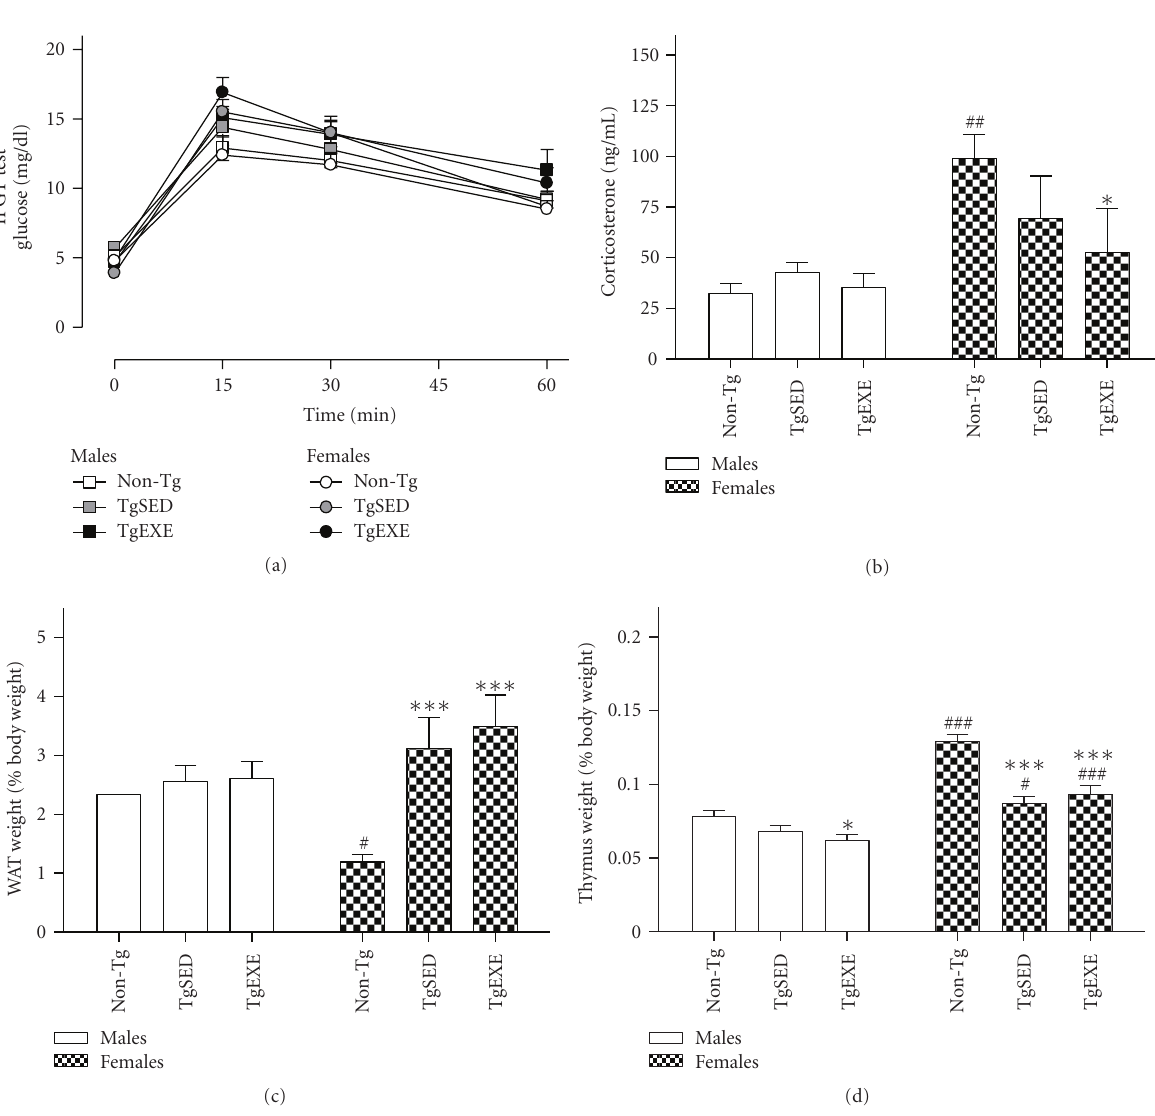
Figure 2: Peripheral physiological-immunoendocrine function is di ff erentially impaired in male and female 3xTg-AD mice and is not ameliorated by treadmill exercise. (a) The IPGT test, indicating plasma glucose levels after an ip injection of glucose, denoted lower tolerance in female 3xTg-AD (see text for statistics). (b–d) Immunoendocrine function as measured by corticosterone plasma levels (b), white adipose tissue (WAT) weight (c), and thymus weight (d) was better in females than in males. Values are the mean ± SEM, n = 8–10. Statistics: ∗ P < . 05 and ∗∗∗ P < . 001 compared to the corresponding non-Tg; # P < . 05, ## P < . 01, and ### P < . 001 compared to the corresponding